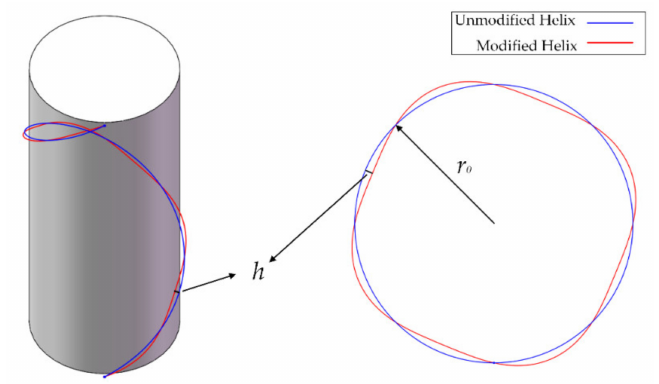
Figure 4. Modified helix